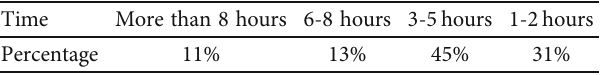
Table 2: Statistics on media exposure time of young